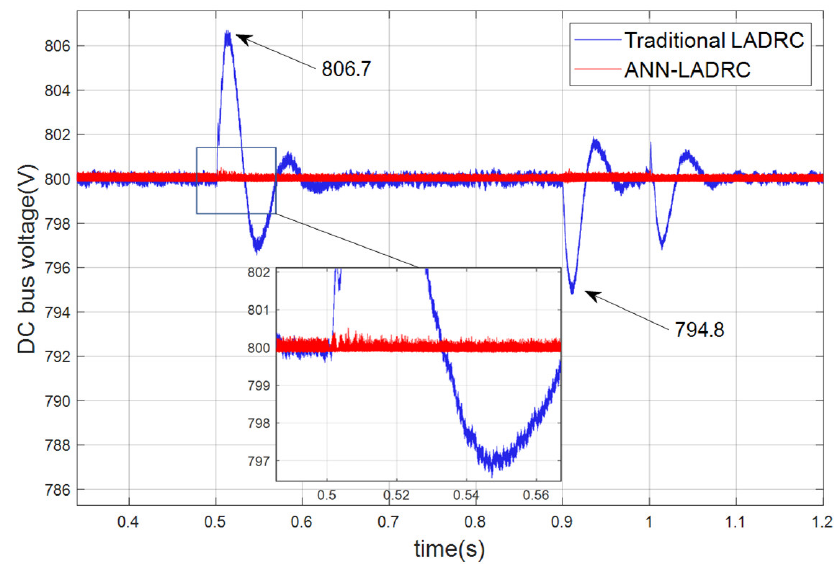
Figure 10. Net-side voltage balance dip 50% bus voltage waveform.